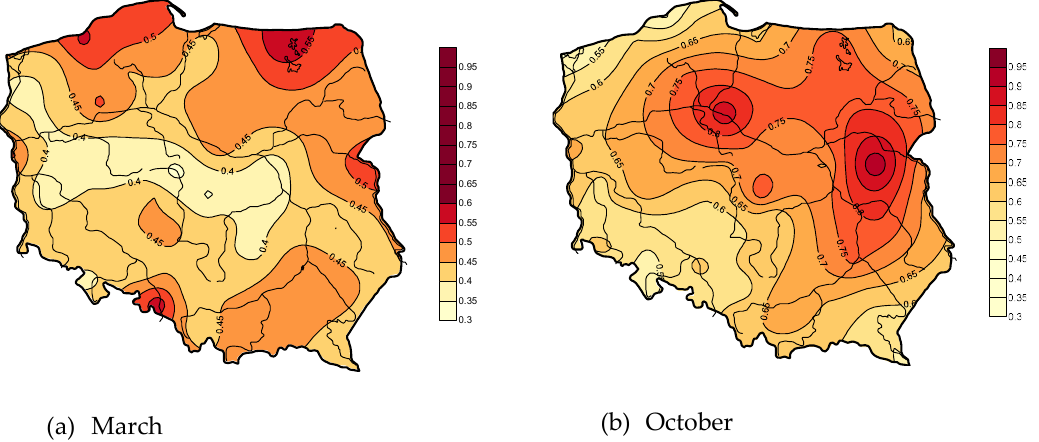
Figure 8. Isarithms of the coe ffi cient of variation of precipitation totals in ( a ) March and ( b ) October in Poland in 2001–2018.